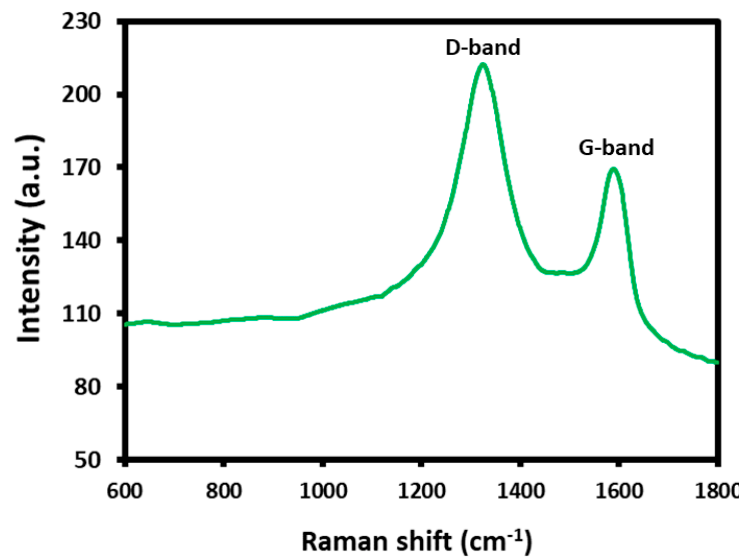
Figure 6. Raman spectrum of HRG@ZrO 2 nanocomposite.